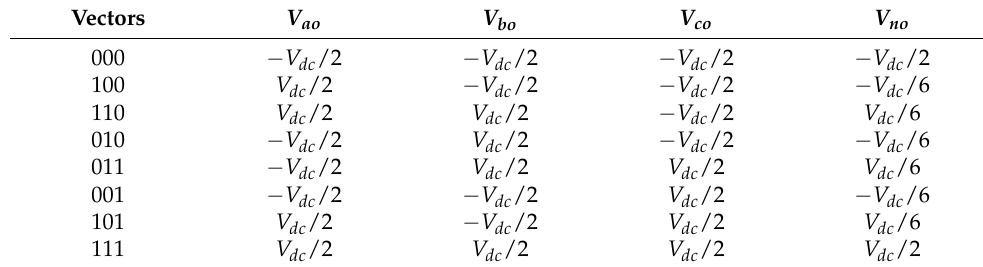
Table 1. Relationship between switching vectors and common-mode voltage.